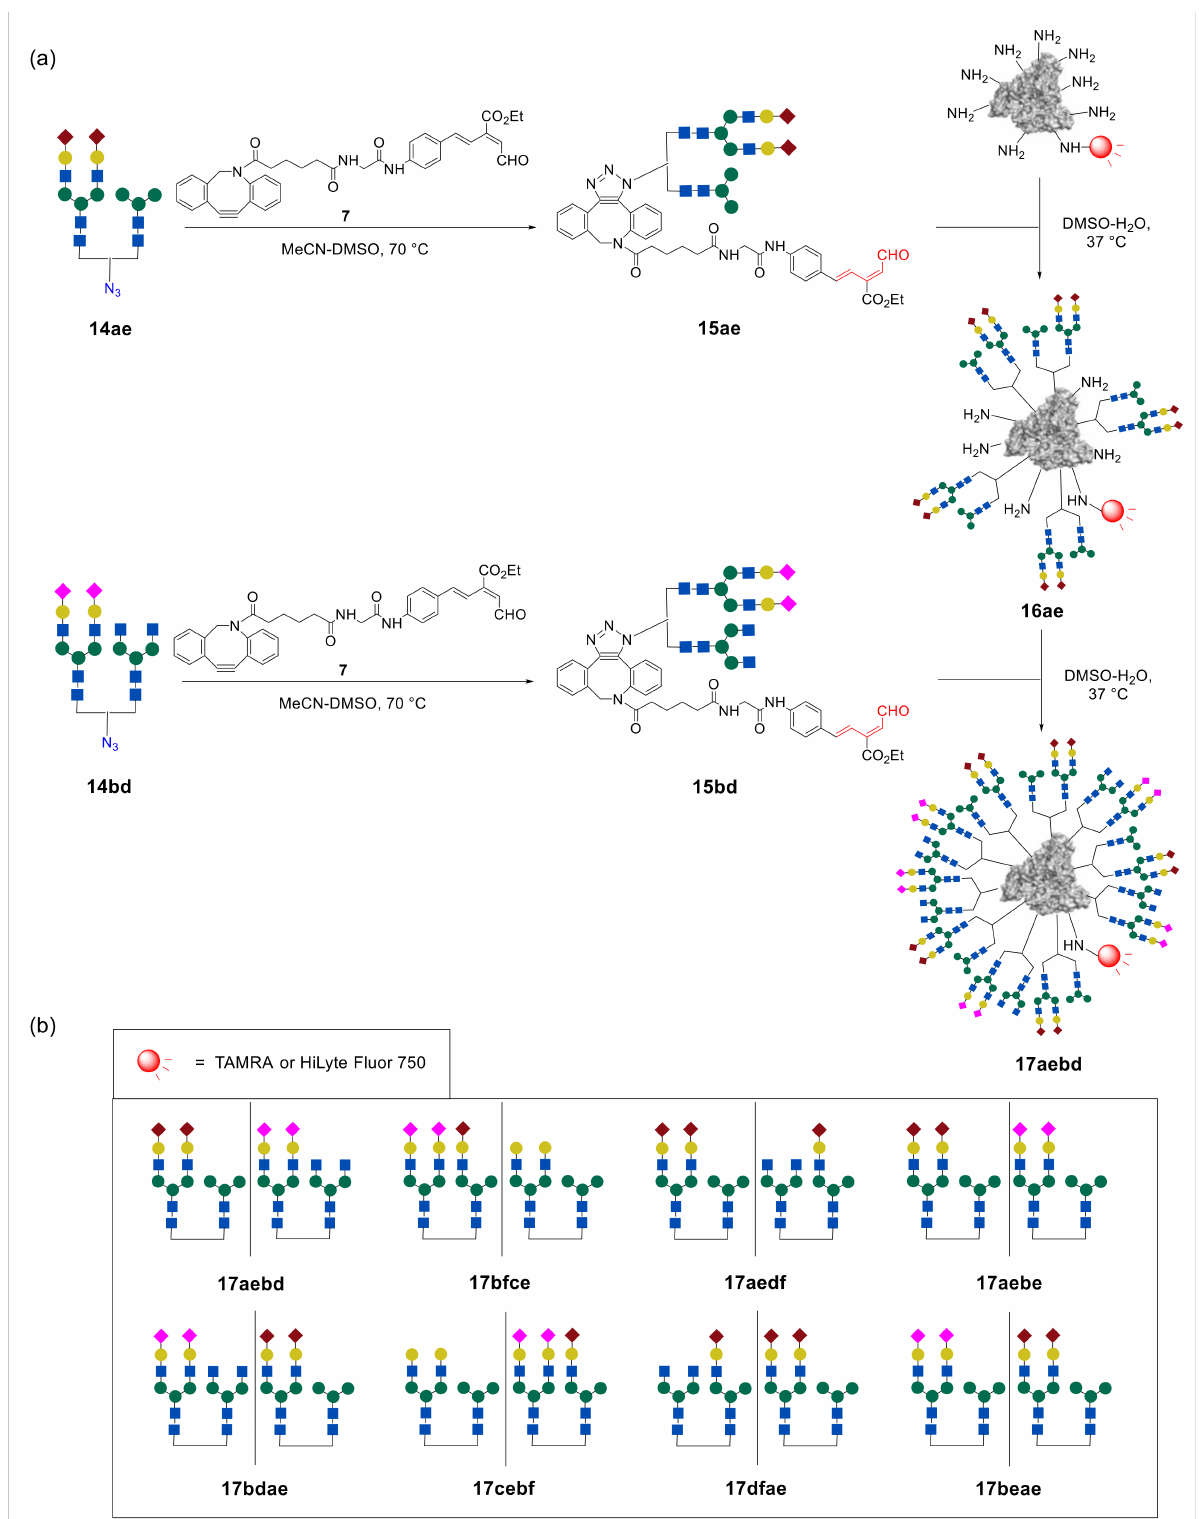
Figure 13. Immobilization of four different biantennary N -glycans on albumin in the synthesis of het- erogeneous glycoclusters with the use of two heterogeneous glycan–aldehydes 15 : ( a ) representative immobilization of glycan–azides 14ae and 14bd onto albumin resulting in the glycoconjugate 17aebd ; ( b ) the range of synthesized glycoalbumins 17 [44]. Copyright Wiley-VCH GmbH. Reproduced with